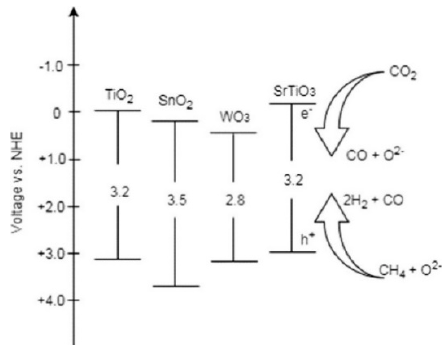
Figure 19. Schematic diagram of the band structure of each catalyst and CO production mechanism during a photocatalytic DRM reaction. Reprinted from [43] with permission from The Chemical Society of Japan.